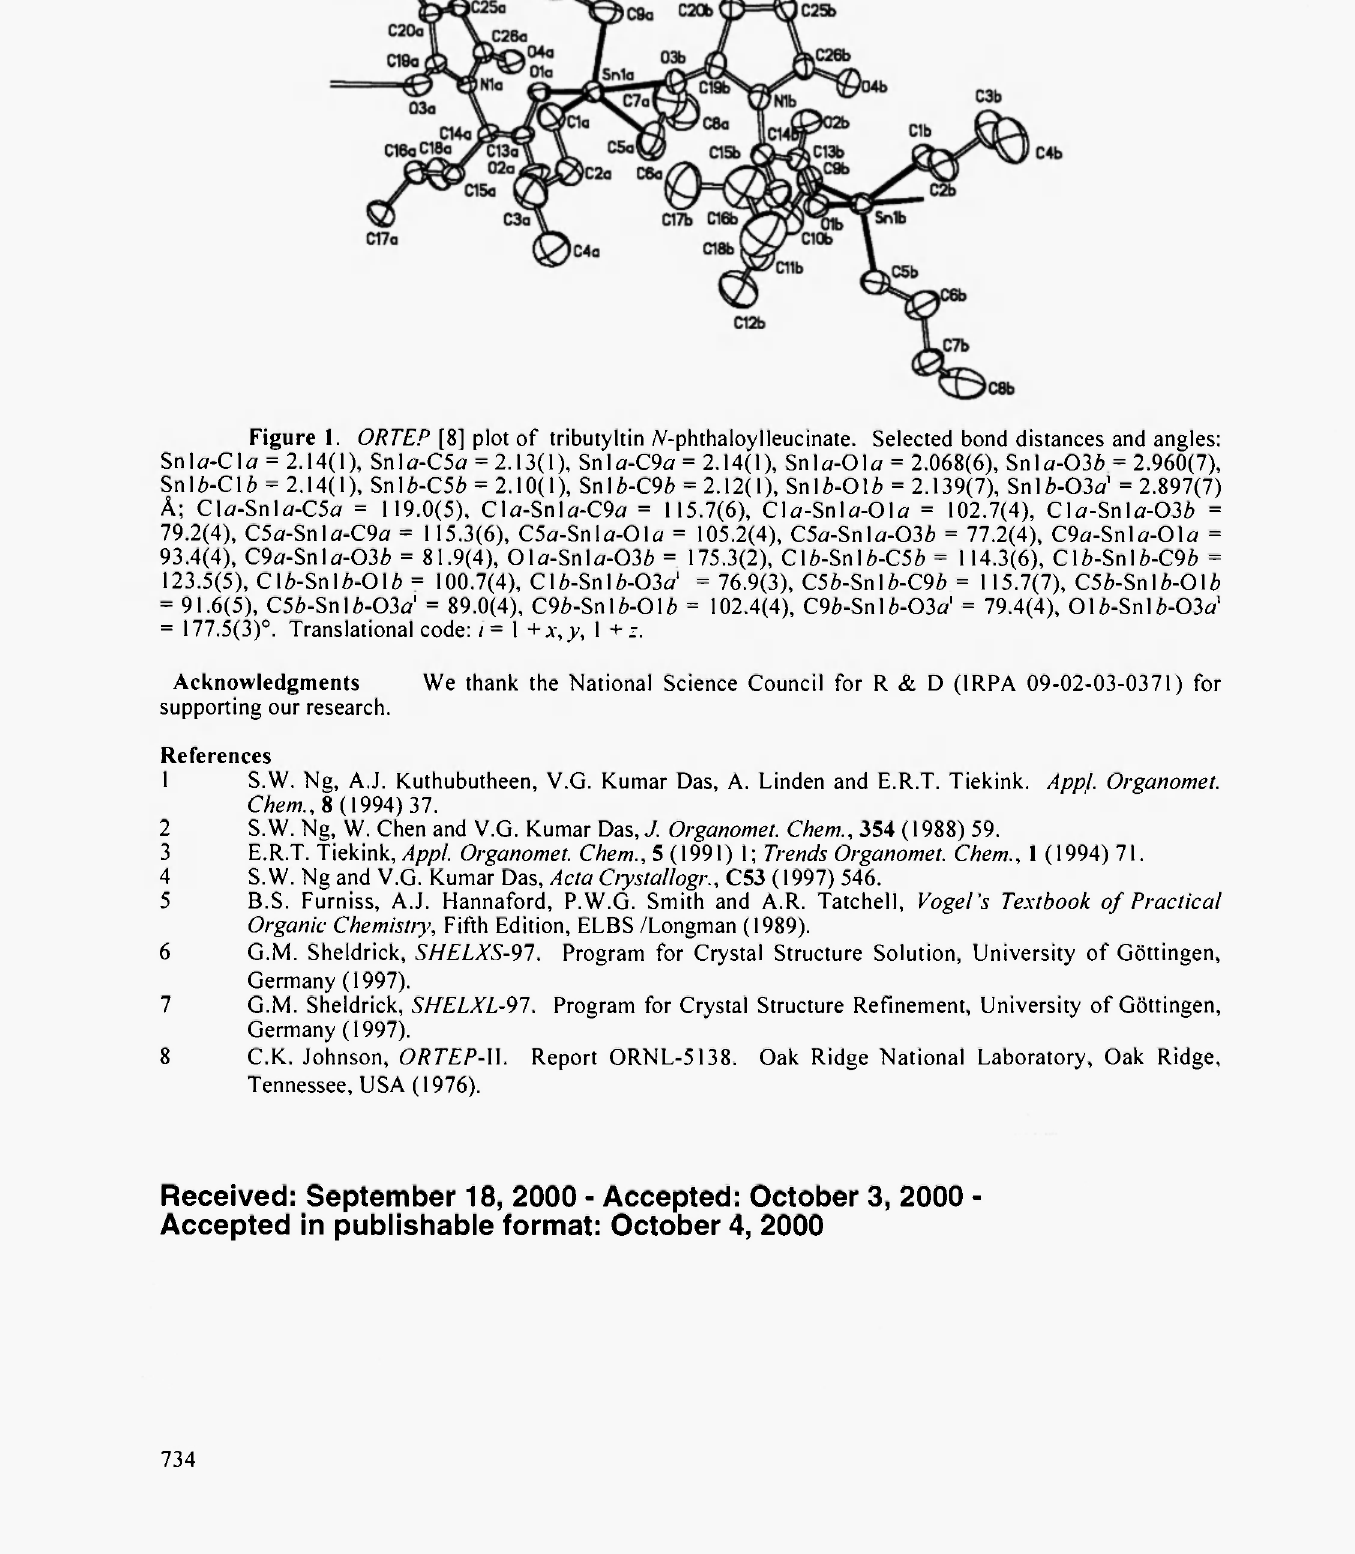
Figure 1. ORTEP [8] plot of tributyItin iV-phthaloylleucinate. Selected bond distances and angles: Snla-Cla = 2.14(1), Snlo-C5o = 2.13(1), Snla-C9a = 2.14(1), Snla-Ola = 2.068(6), Snla-036 = 2.960(7),